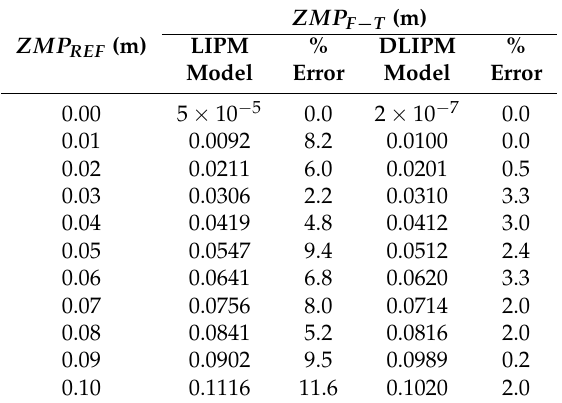
Table 1. ZMP comparison using the LIPM and DLIPM.